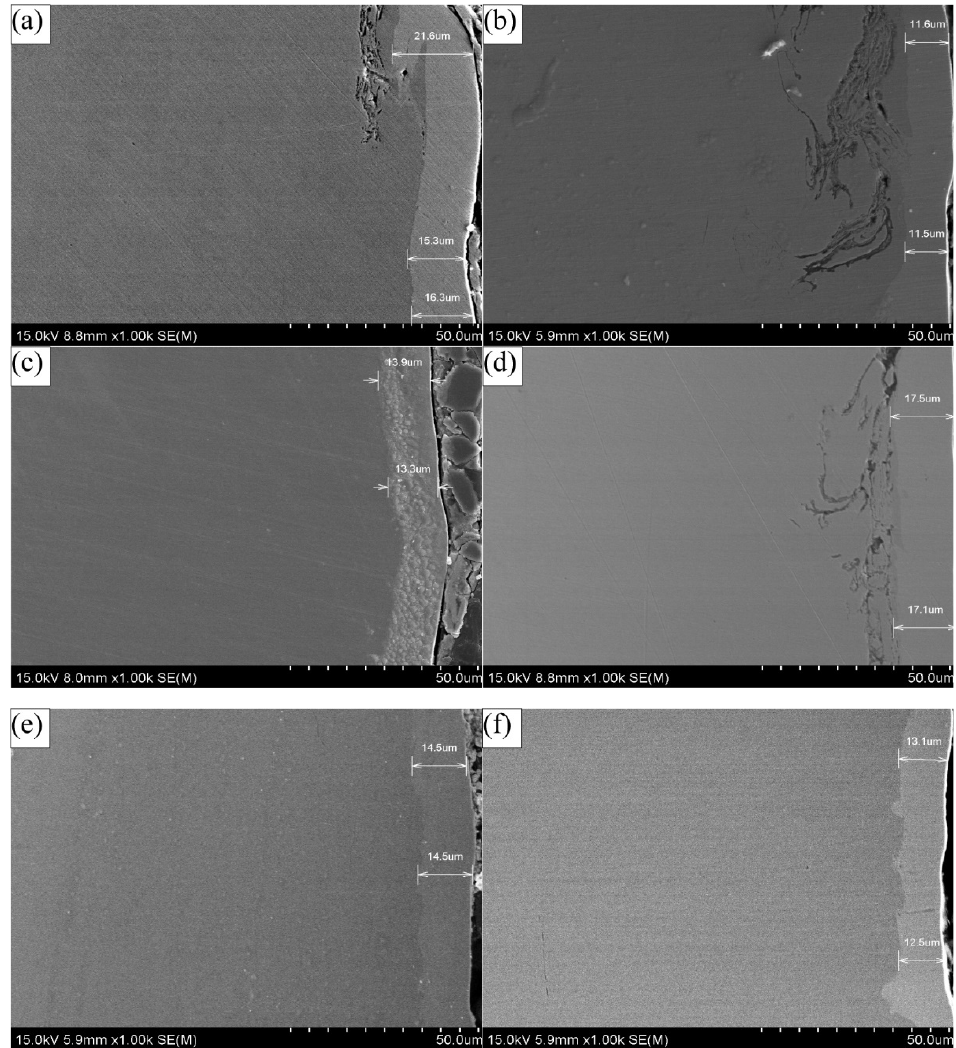
Figure 3. Cross-sectional microstructure of the composite coatings with different particle concentra- tions (( a ) 0, ( b ) 1, ( c ) 2, ( d ) 3, ( e ) 4, and ( f ) 5 g·L − 1 ) prepared on 45 steel substrates through scanning electrodeposition.